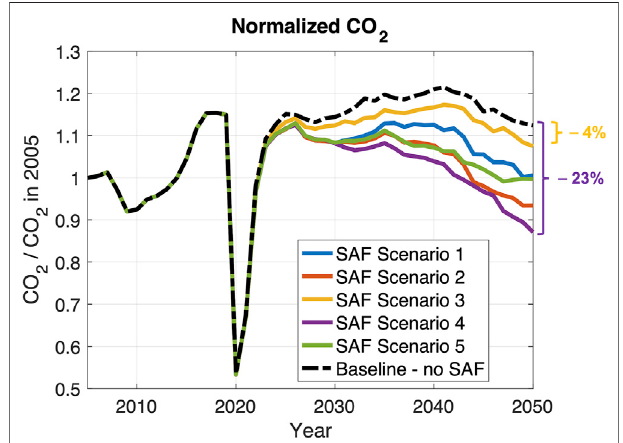
FIGURE 7 | Normalized fl eet-level CO 2 emissions for SAF scenarios (considering passenger demand recovery to pre-COVID-19 levels by 2023);